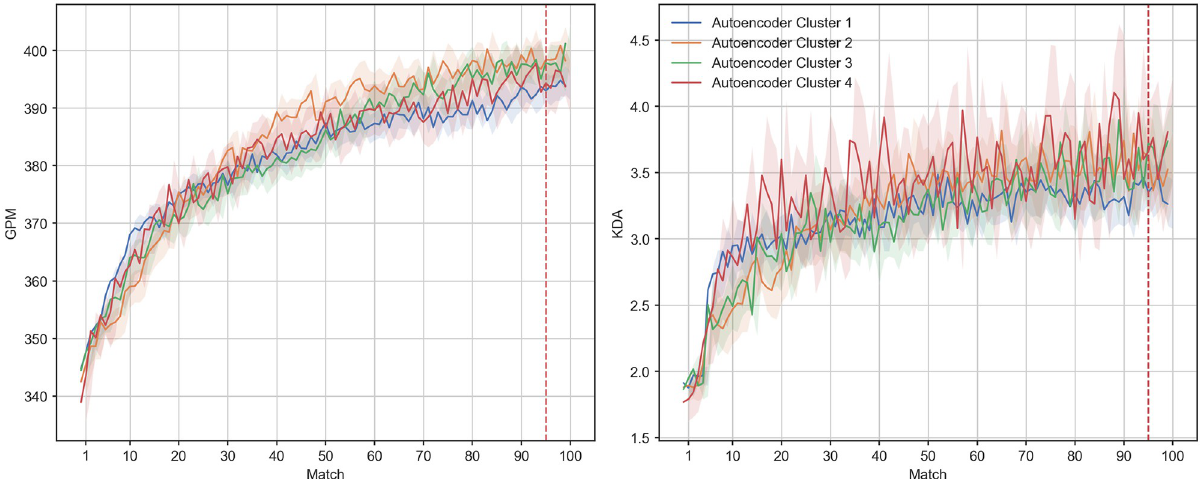
Fig 6. Trajectories of mean GPM (left panel) and KDA (right panel) against match for players in our 4 autoencoder clusters. Data in the figure are a subsample of players who intiate at a similar range of GPM and KDA (approximately surrounding the original sample median). Shaded regions indicate 95% confidence